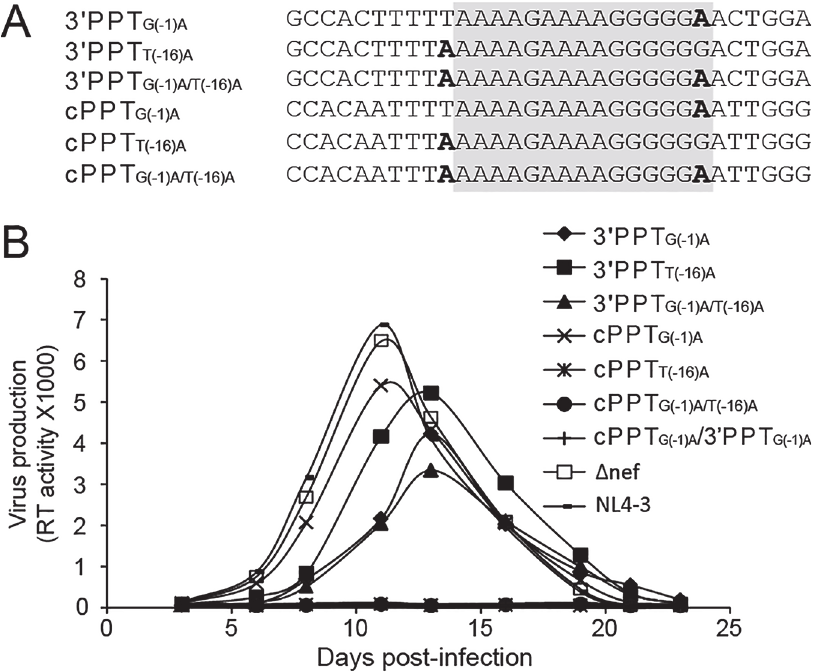
Fig 3. Replication of 3 0 PPT and cPPT mutant viruses. (A) Introduction of single and double mutations into the 3 0 PPT or cPPT region in an NL4-3 backbone through yeast based/HIV-1 cloning technology [33]; (B) Replication of various PPT mutants, as well as Δ nef mutant (with premature stop codon in nef but outside of PPT region) in U87.CD4.CXCR4 cells. The input viruses were normalized according to RT activity.